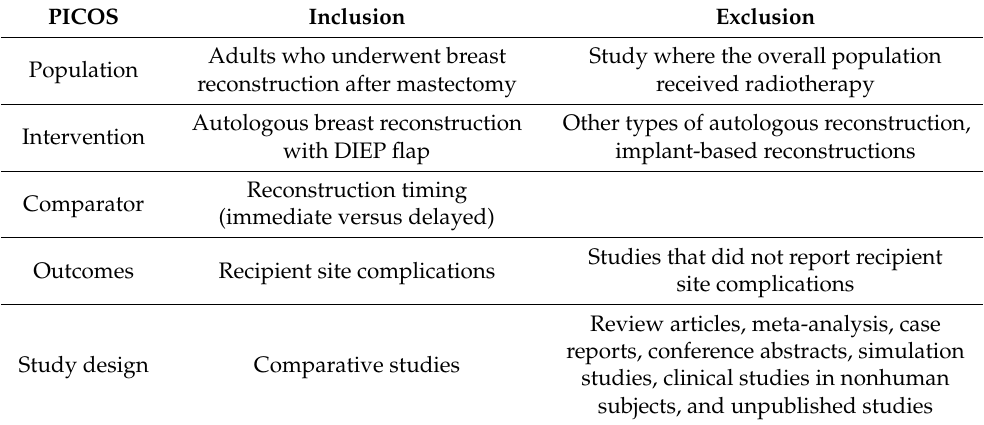
Table 1. PICOS table features. PICOS Inclusion Exclusion Adults who underwent breast Study where the overall population Population reconstruction after mastectomy received radiotherapy Autologous breast reconstruction Other types of autologous reconstruction, implant-based